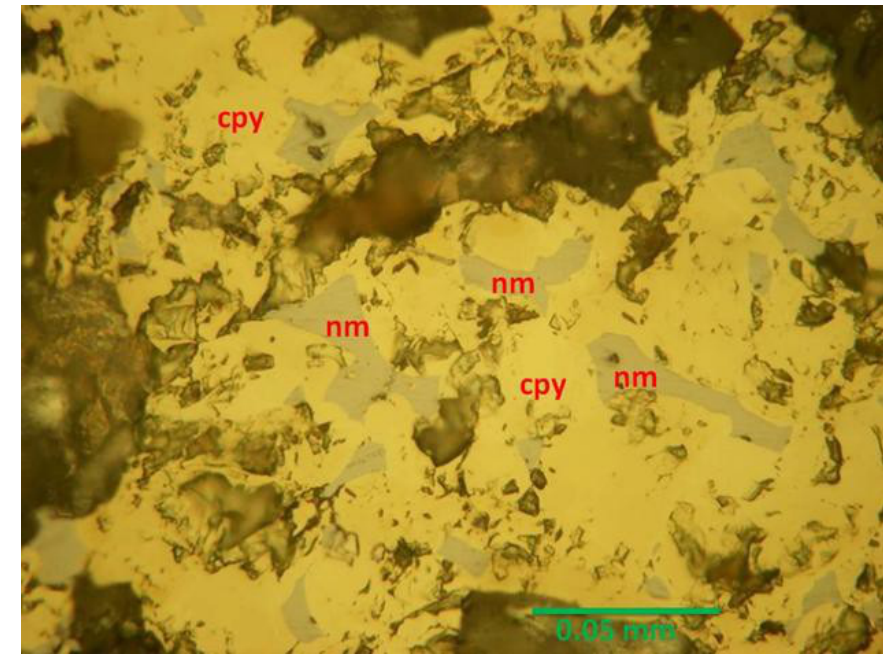
Figure 7. Photomicrograph (reflected light) of chalcopyrite-rich zone from top of Figure 6. It appears that chalcopyrite (cpy) is encrusting and replacing the former “top” of the naumannite dendrite, and naumannite (nm) is present only as un-replaced “islands” in massive